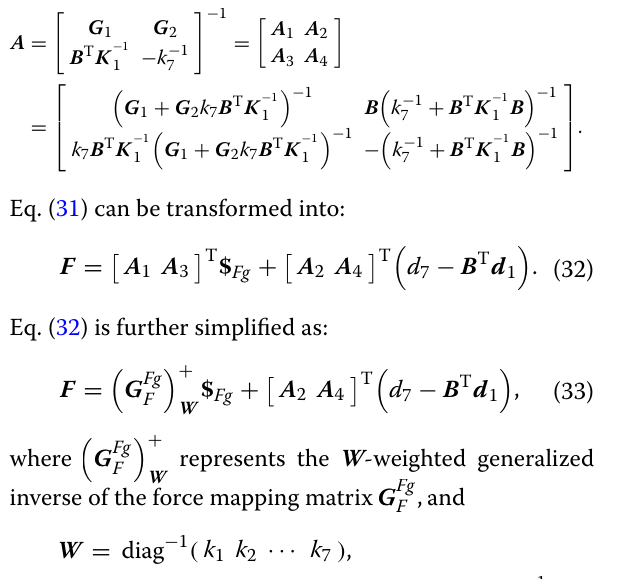
Figure 6 The 2SPS P passive-input overconstrained mechanism +